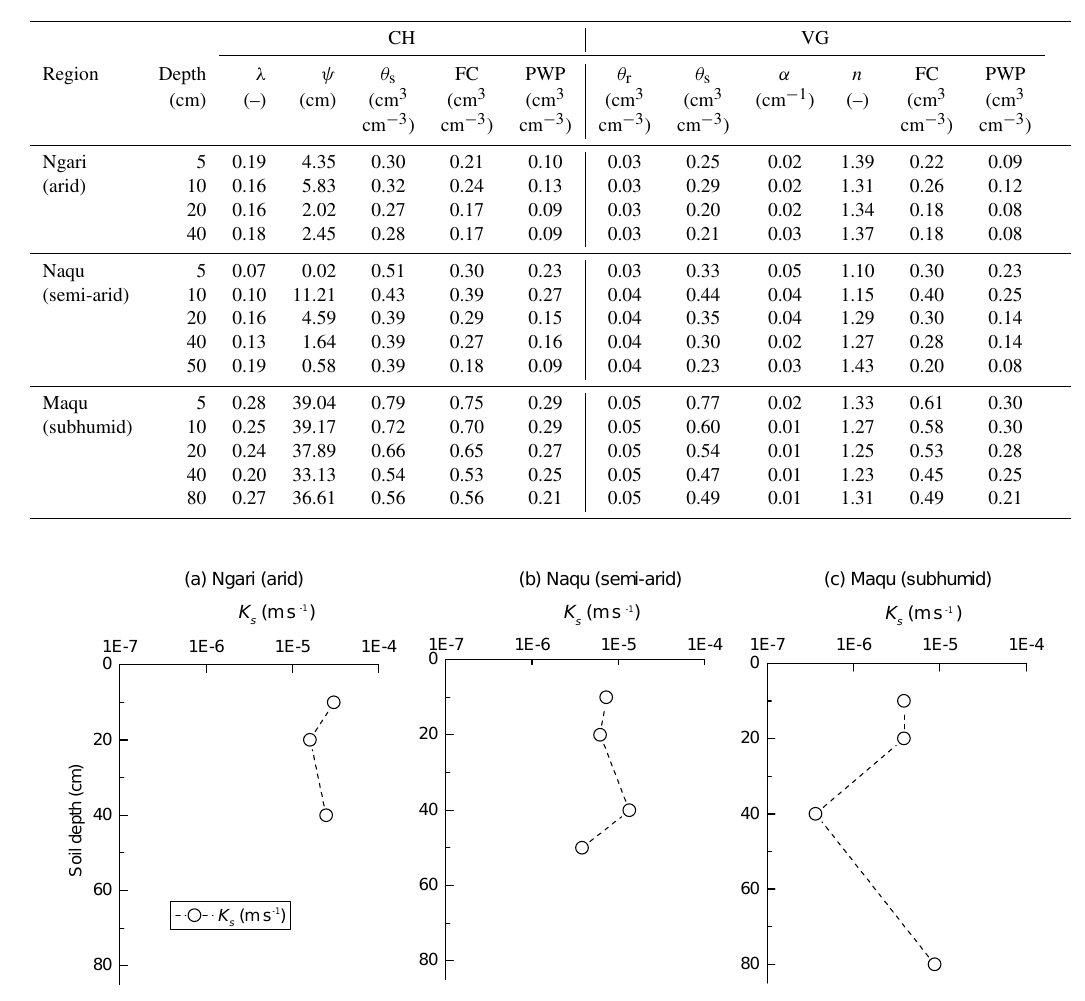
Table 2. Pressure-cell determined parameters of the CH and VG models for the three climate zones. The scaling method used for the determination is Eq. (A15) in the Appendix.